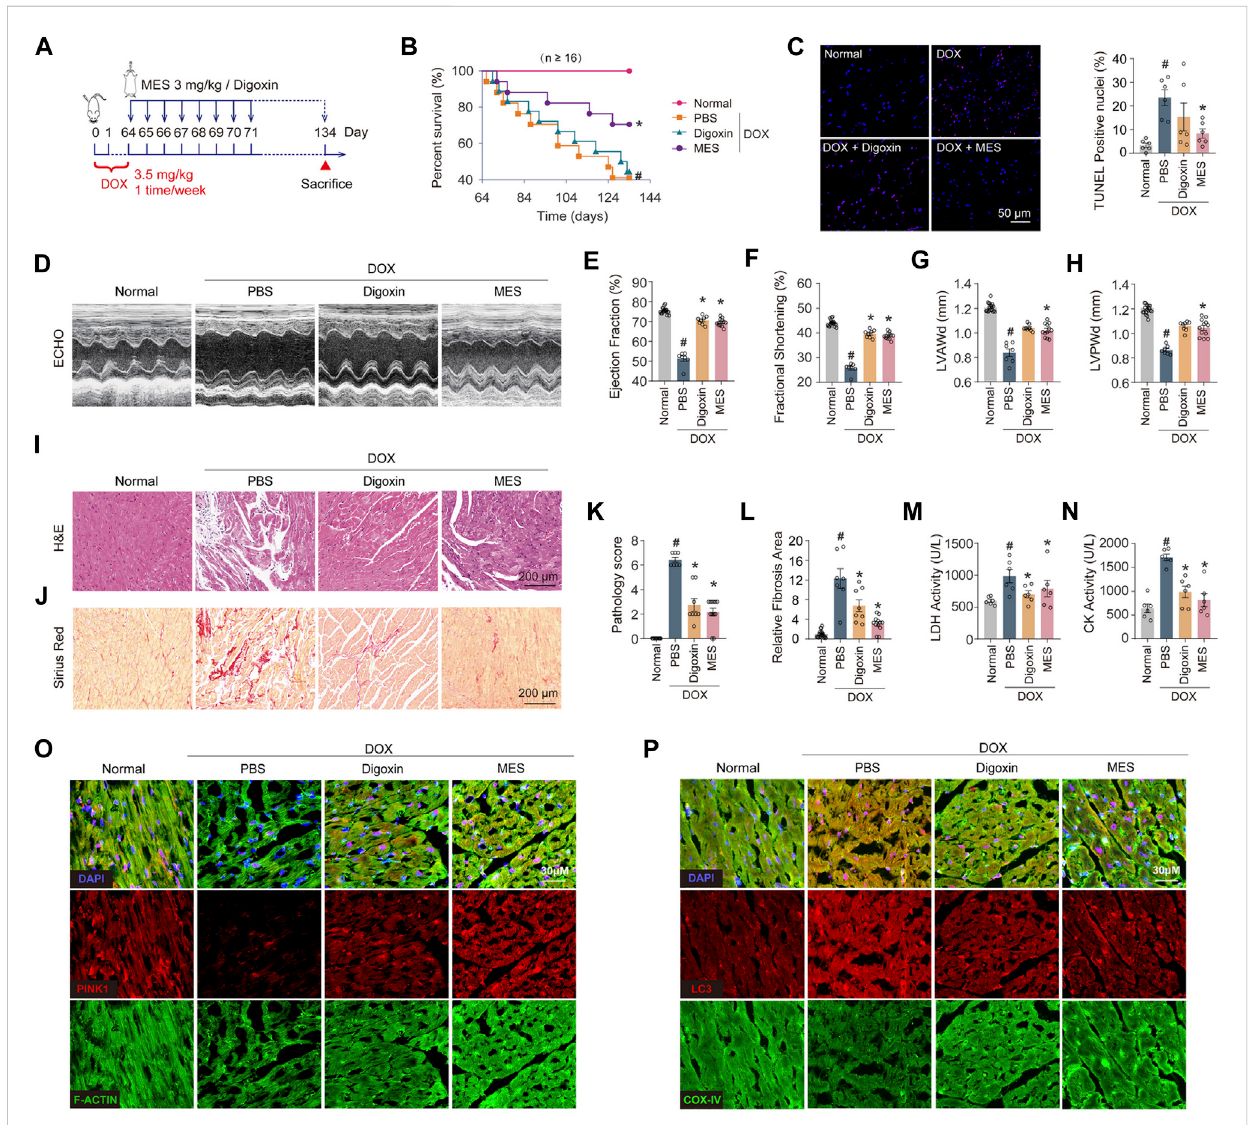
FIGURE 6 Mesaconine treatment improved left ventricular dysfunction and abnormal myocardial remodeling in DOX-induced chronic heart failure mice. (A) The schematic diagram for preparing the heart failure model and corresponding treatments. (B) Survival rate curves were analyzed by the Kaplan-Meier method and compared by the log-lank test. (C) The TUNEL assay and quantitative analysis in the myocardium. (D) Representative images of left ventricular (LV)M-mode echocardiograms. (E – H) The LV ejection fraction (E) , fractional shortening (F) , diastolic anterior wall thickness (LVAWd, (G) andposteriorwallthickness(LVPWd, (H) weremeasuredtoevaluatethecardiacsystolicfunctionandstructure. (I,J) RepresentativeimagesofH&E (I) and Sirius Red (J) staining of the heart sections. (K, L) Quantitative analysis of myocardial histopathological scores (K) and collagen deposition (L) . (M, N) The serum activity of LDH (M) and CK (N) . (O) Levels of PINK1 in myocardial tissues were analyzed by immunostaining. (P) Colocalization of LC3 and COX-IV was examined by confocal analysis. Data are represented as means ± SEM (n ≥ 7). *, # p <